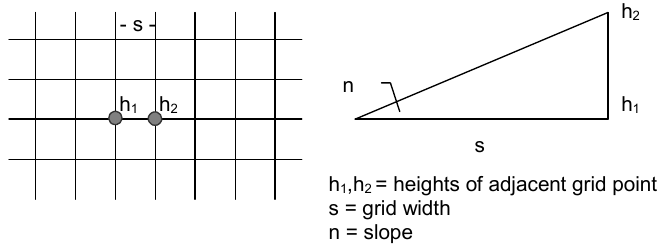
Figure A1. Digital height model: grid width, heights, slopes.